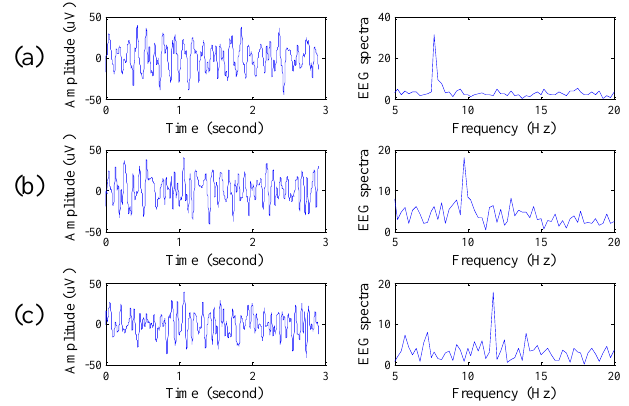
Figure 6. EEG signals and EEG spectra for SSVEP experiment with ( a ) 8 Hz; ( b ) 10 Hz; and ( c ) 12 Hz flashing light sources.